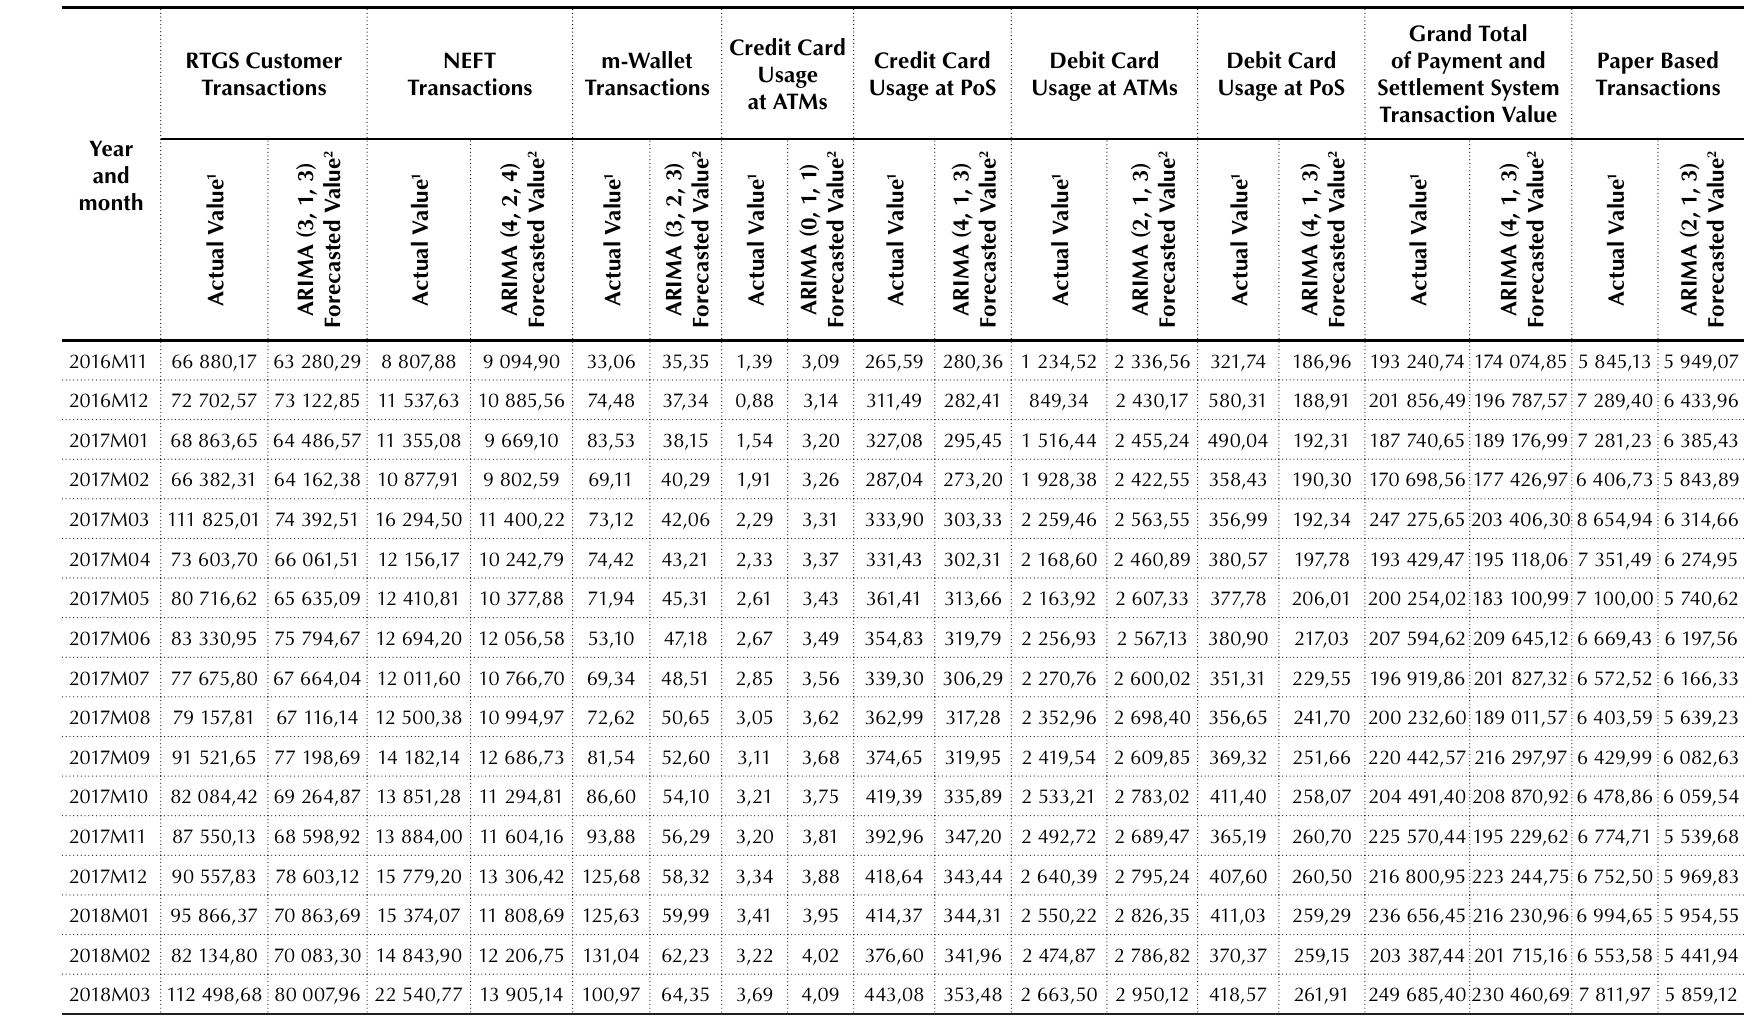
Table 1. ARIMA (p, d, q) estimations and actual value of transactions (November 2016 to March 2018) Sources: 1 The data used for the study downloaded from the database on Indian economy available at https://dbie.rbi.org.in/DBIE/dbie.rbi?site=home . 2 Estimated by the